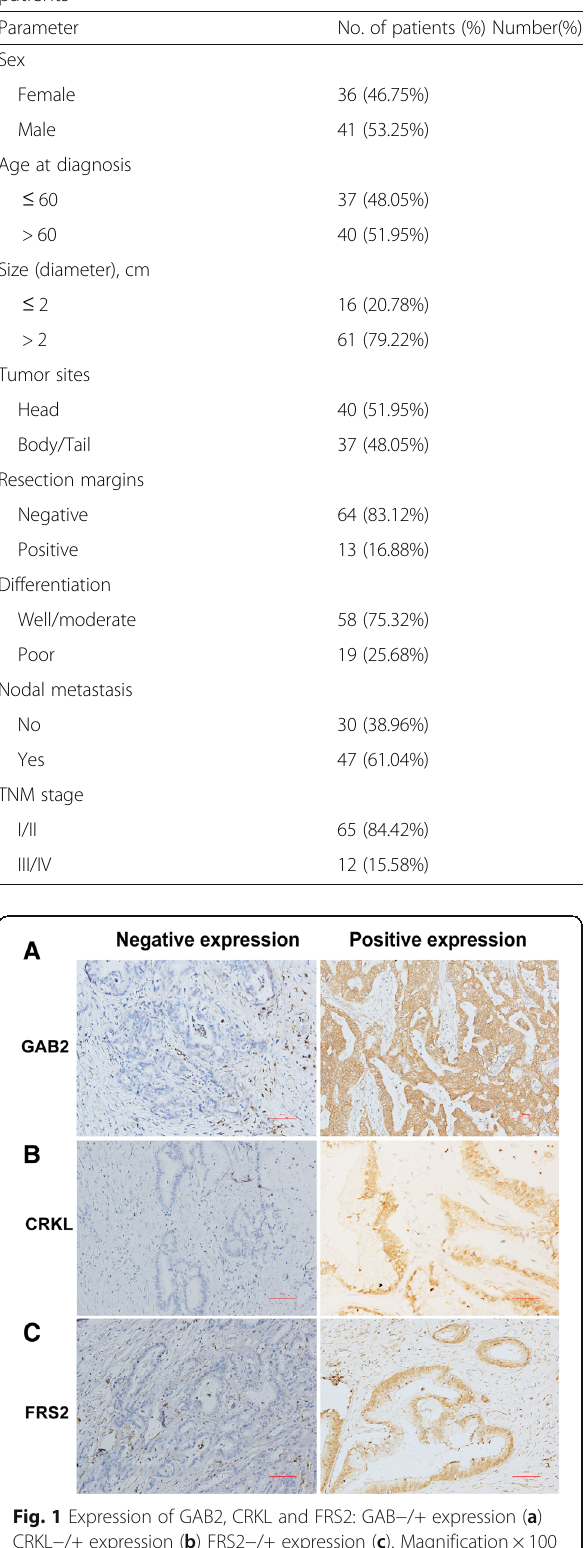
Table 1 Clinical and pathological characteristics of PDCA